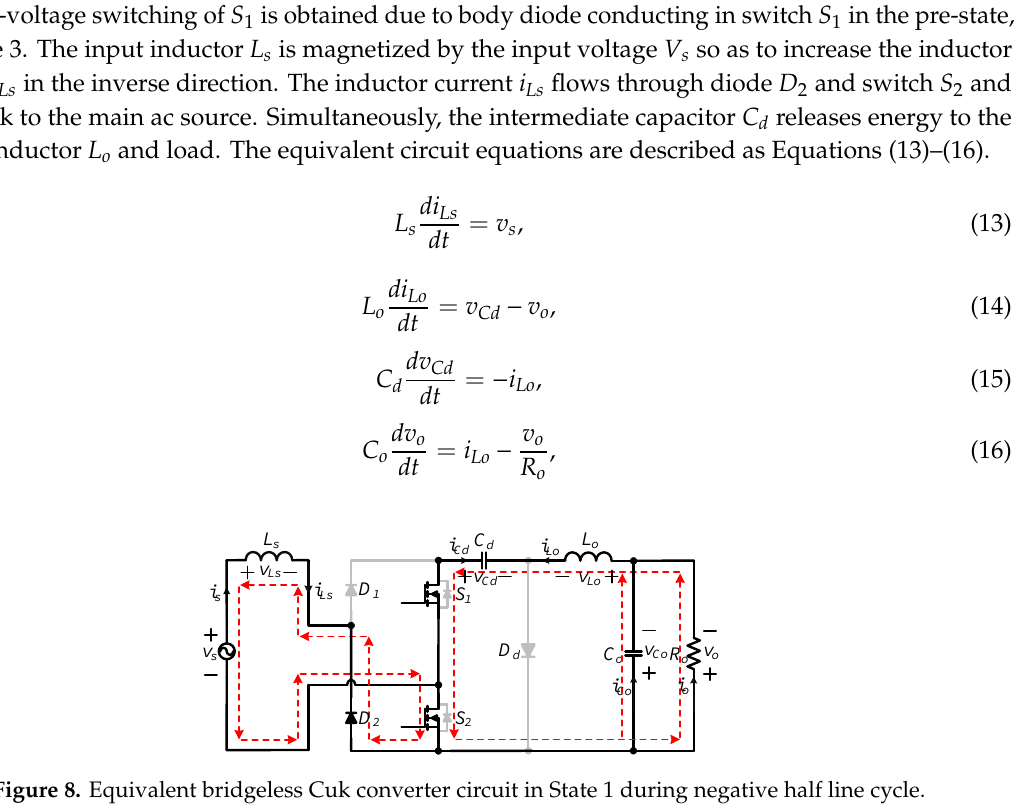
Figure 7. Equivalent circuit of the bridgeless Cuk converter in State 3 during positive half line cycle.